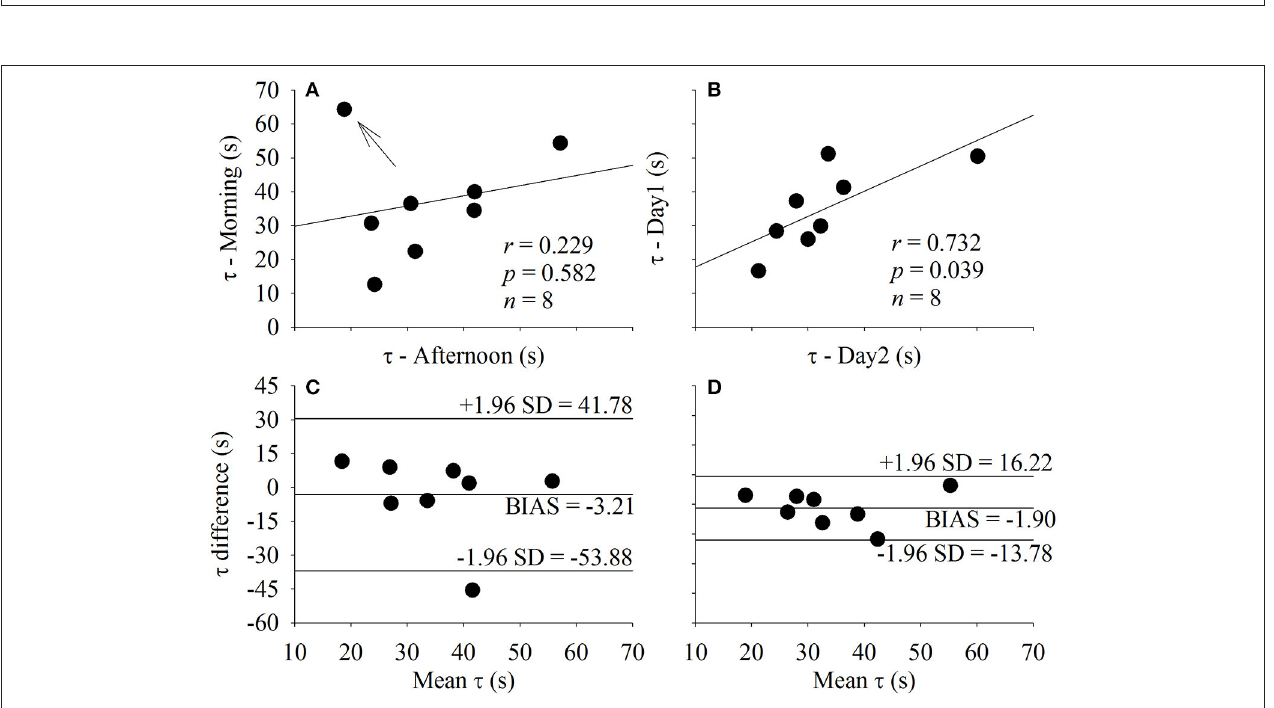
FIGURE 5 | Correlation between the mean normalized gain amplitude ( MNG ) estimated under the influence of different time of the day ( A , Morning vs. Afternoon) and different day of testing ( B , Day 1 vs. Day 2). The agreement level between the factors plotted in (A,B) are displayed in (C,D) , respectively. r , Pearson’s correlation level; p , statistical significance level; and n , sample size.